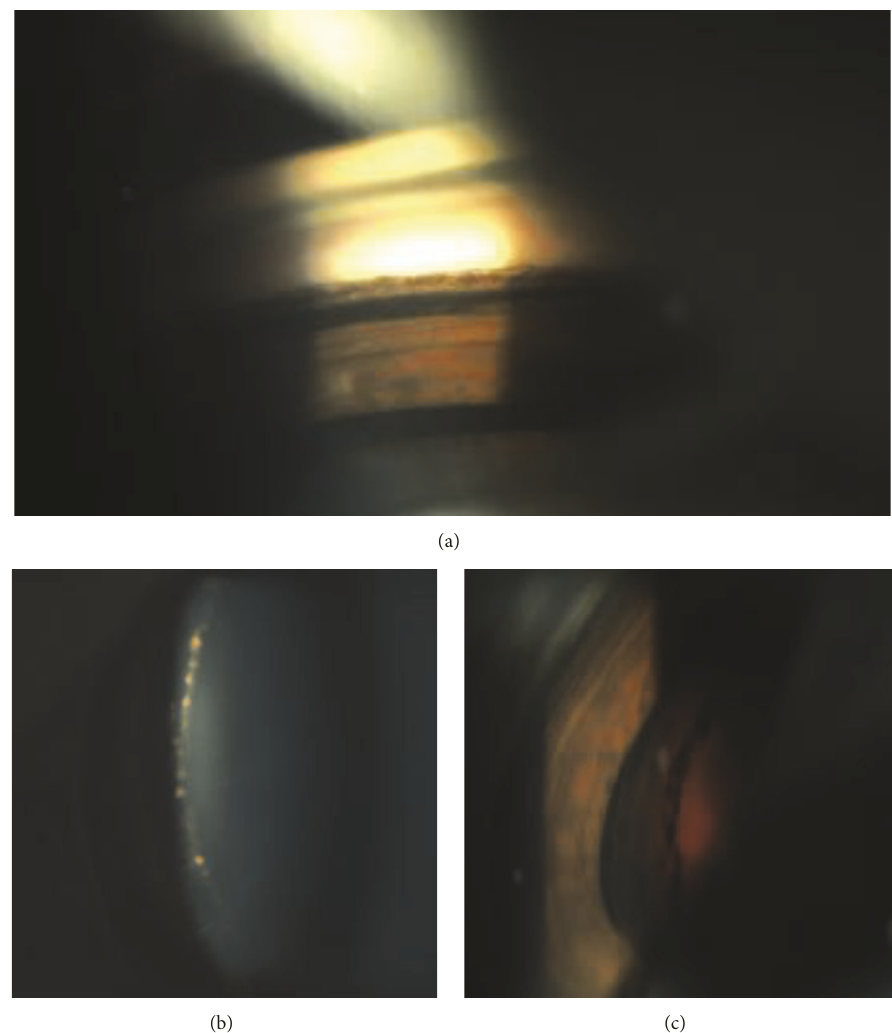
Figure 1: (a) Increased trabecular pigmentation (b) (c) Zentmayer ring. Pigment accumulated at the zonular attachments to the